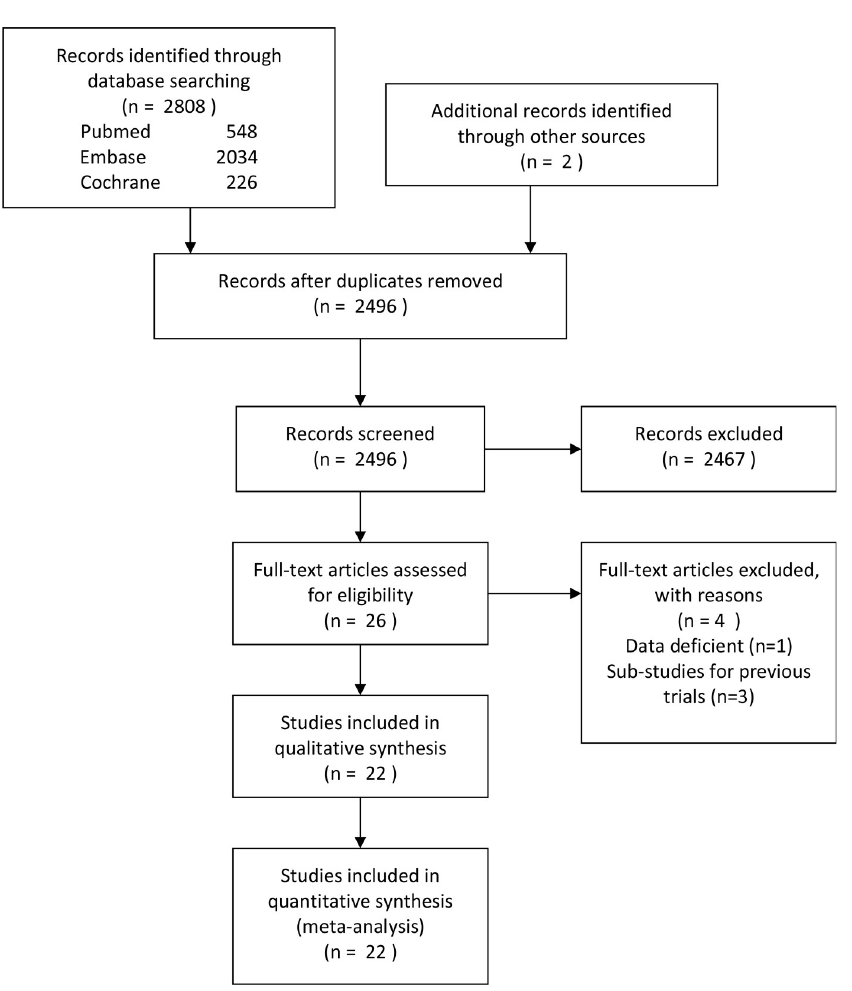
Fig 1. Flow diagram of study